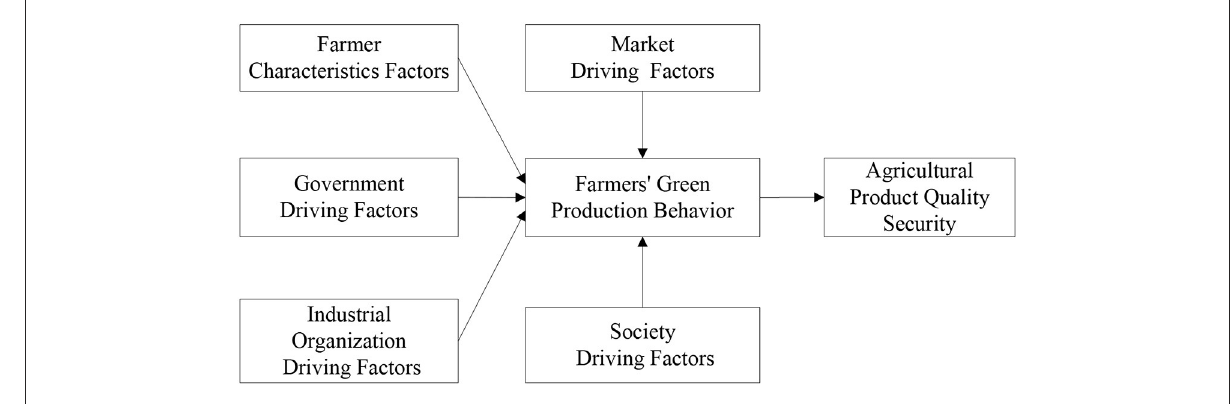
FIGURE1 Hypothesized model.